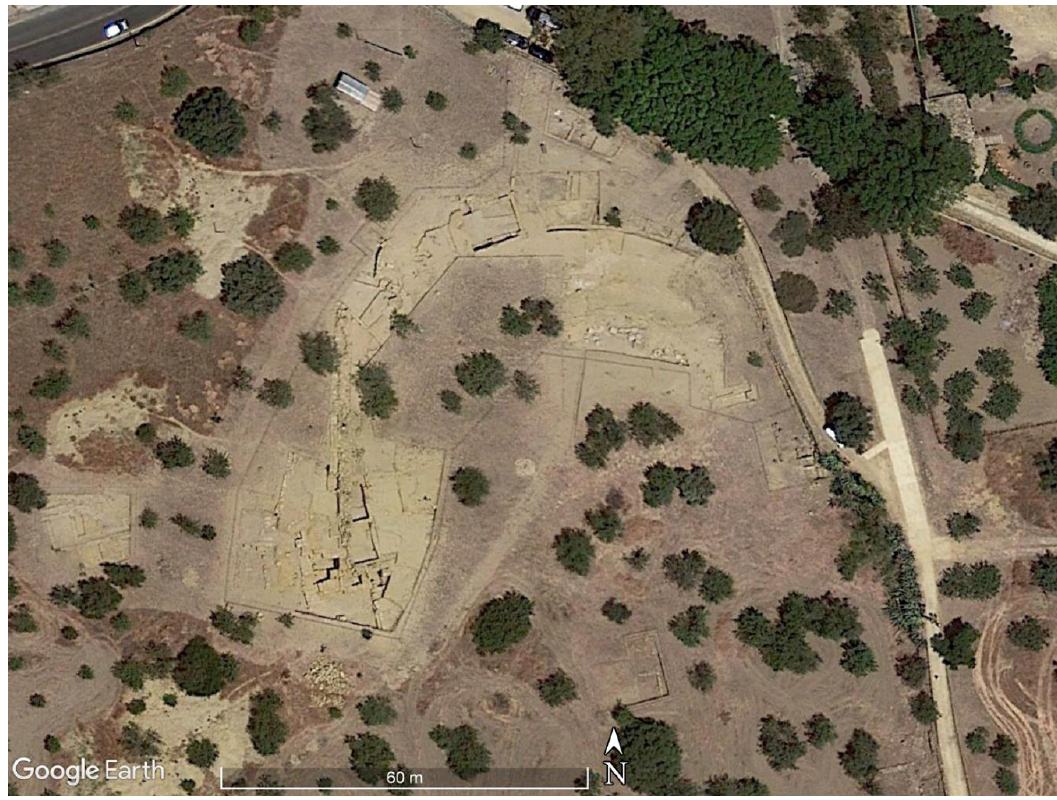
Figure 14. Google Earth TM satellite image acquired in 2019.